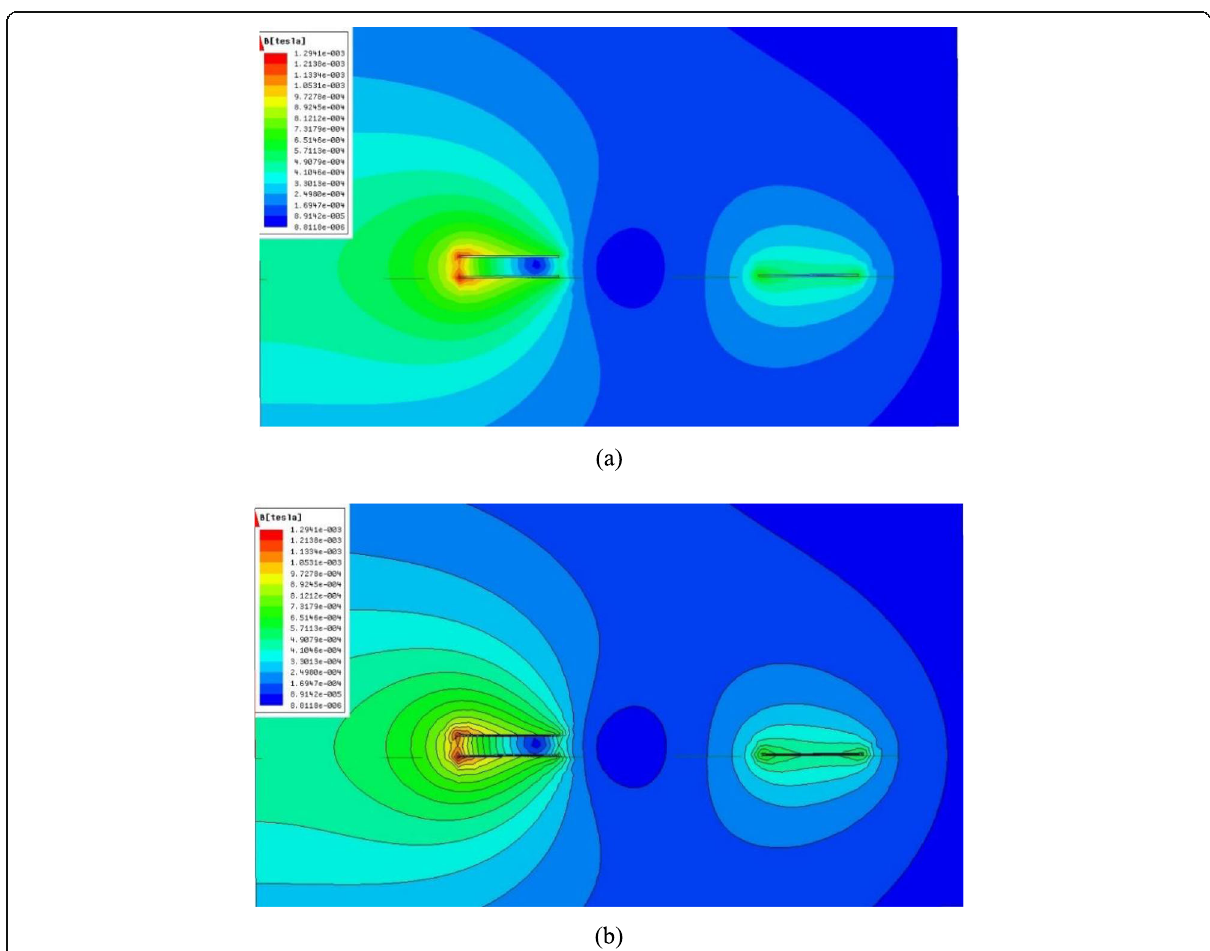
Fig. 9 Magnetic field distribution of asymmetric coupling coil structure. a Magnetic field without equipotential line. b Magnetic field with equipotential line